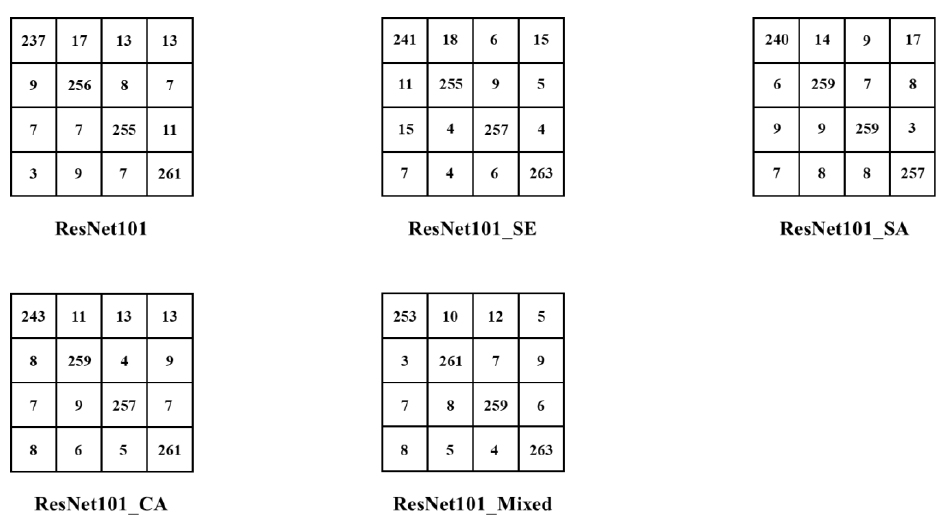
Figure 8. Confusion matrices of ResNet101 models with visual attention blocks to further demonstrate the classification performance.